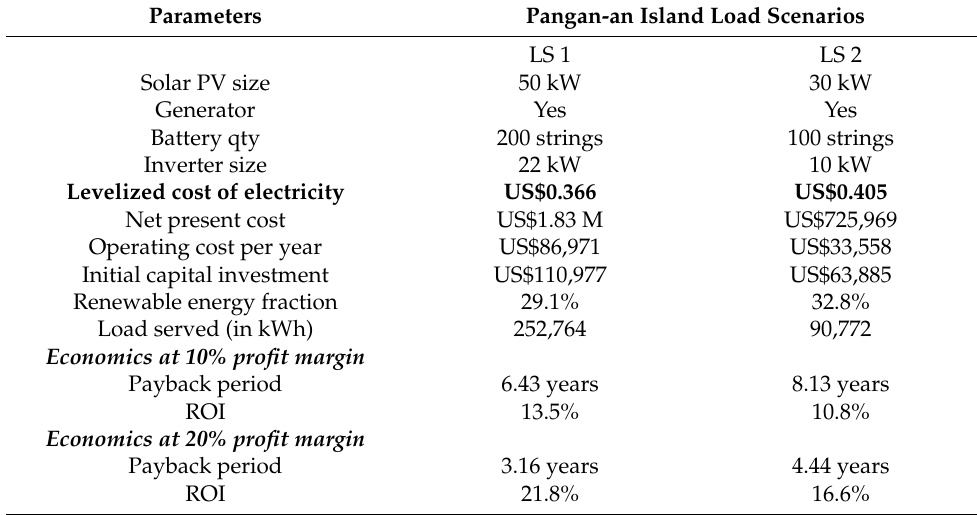
Table 4. System design optimization and economic results (Pangan-an).